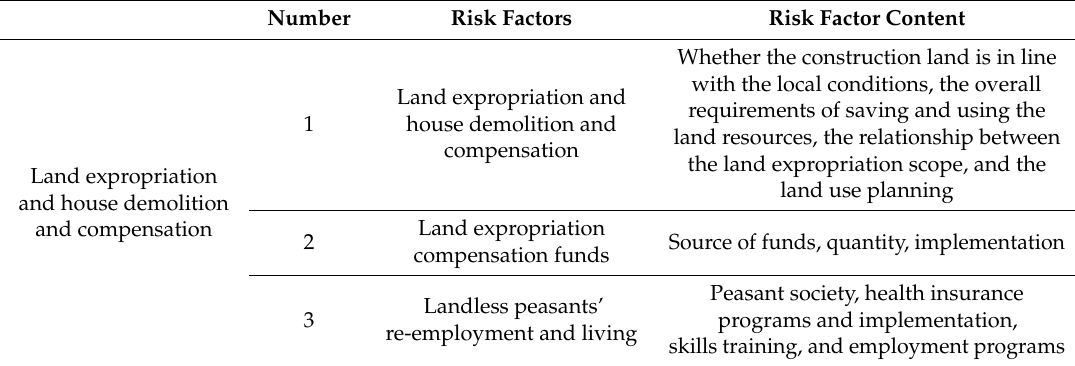
Table 2. Social stability risk factor identification table